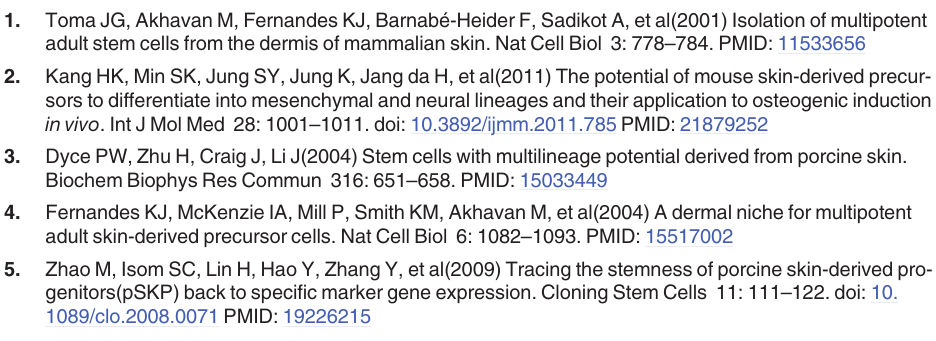
S1 Fig. The detailed information of TGF- β signaling pathway. Up-regulated genes are marked with red borders and down-regulated genes with green borders. S2 Fig. The detailed information of Wnt signaling pathway. Up-regulated genes are marked with red borders and down-regulated genes with green borders. S3 Fig. The detailed information of Notch signaling pathway. Up-regulated genes are marked with red borders and down-regulated genes with green borders. S1 Table. KEGG pathway enrichment analysis of